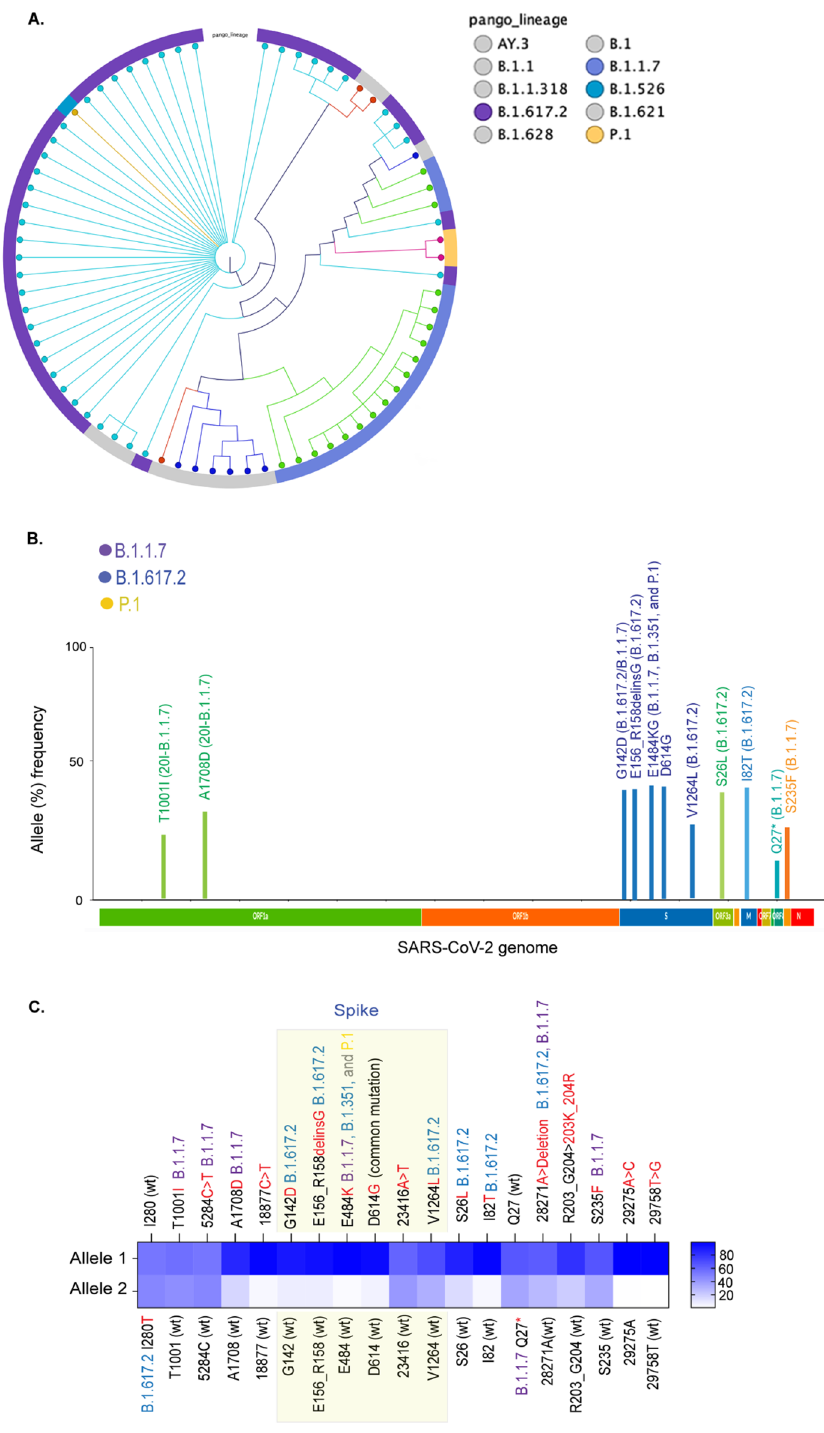
Figure 4. Detection of SARS-CoV-2 specific signatures in the wastewater and their correlation with the variants circulating in the community during the month of June 2021. Figure generated using NextStrain 20 . ( A ) Lineage distribution of SARS-CoV-2 variants circulated in the community identified though individual level testing. These variants are classified based on the Nextclade as well as pangolin lineages. ( B ) Relative allele frequencies of the key mutations, important in defining variants, detected in the wastewater during June 2021. ( C ) Heat-map showing the relative abundance of the variant defining allelic mutations in the sequence reads. Allele 1 mutation was present in the maximum number of reads, Allele 2 was present in the remaining reads covering those indicated